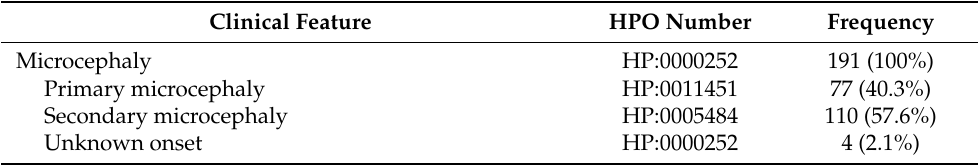
Table 1. Major clinical features and their frequency in patients enrolled in this